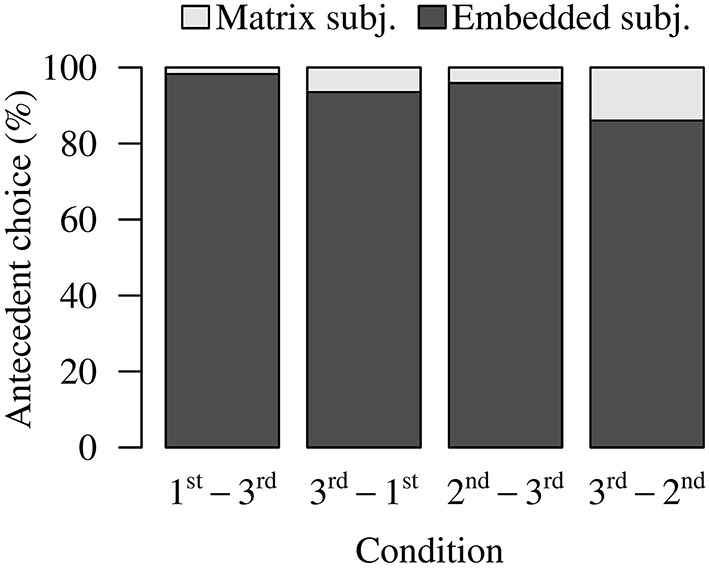
Experiment 3 antecedent choice data.